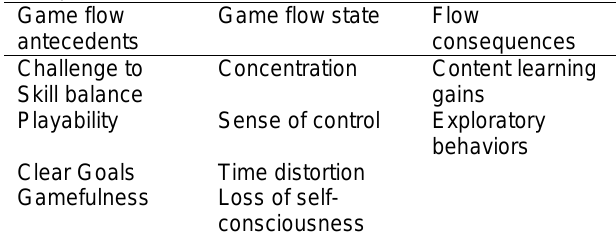
Table 1: The Three Stage Game Flow Model adopted from